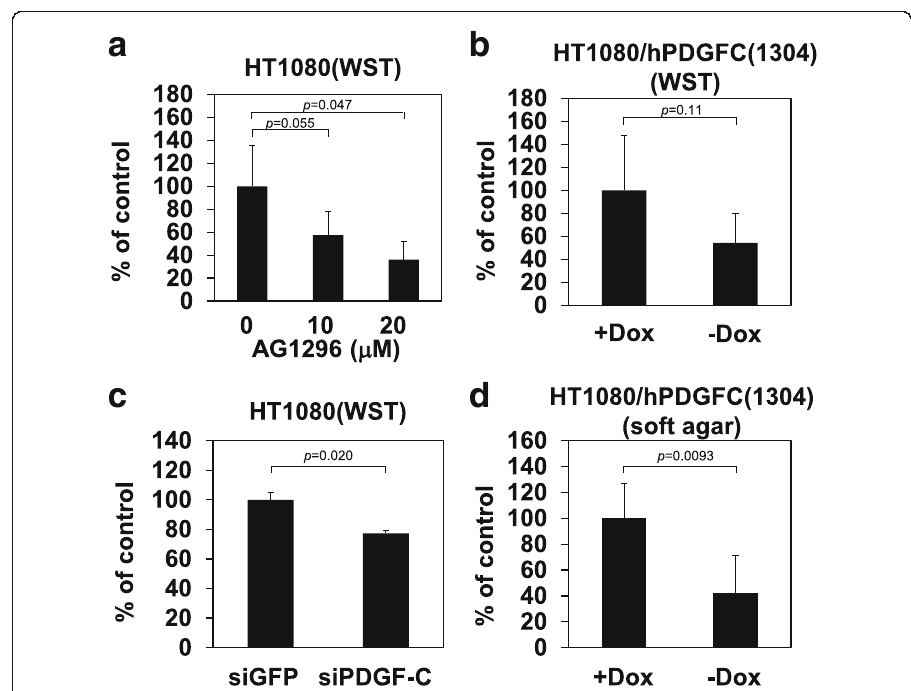
Fig. 2 The inhibition of PDGF-C results in HT1080 cell growth retardation. a The PDGF-R inhibitor suppresses the growth of HT1080 cells. HT1080 cells were cultured for 3 days with the indicated concentrations of AG1296 and subjected to the WST assay. b and c PDGF-C knockdown reduces the growth of HT1080 cells. b HT1080/ hPDGFC(1304) cells were treated with (+) or without ( − ) doxycycline (Dox) for 3 days and subjected to the WST assay. Notably, the expression of PDGF-C was repressed in the absence of doxycycline in HT1080/hPDGFC(1304) cells. c HT1080 cells were transfected with 500 nM of PDGF-C-specific siRNA (siPDGF-C) or negative control siRNA (siGFP), and subjected to the WST assay after a 3-day culture. d PDGF-C knockdown inhibits anchorage- independent growth of HT1080 cells. HT1080/hPDGFC(1304) cells were subjected to the soft agar assay with or without Dox for 2 weeks. In all the experiments, the average result for the control samples was set to 100%, and the bars and error bars respectively represent the means and standard deviations ( n =3). Statistical analysis was performed using the two-tailed paired t test. Statistical significance is defined as p <0.05. The raw data are shown in Additional file 1: Figure